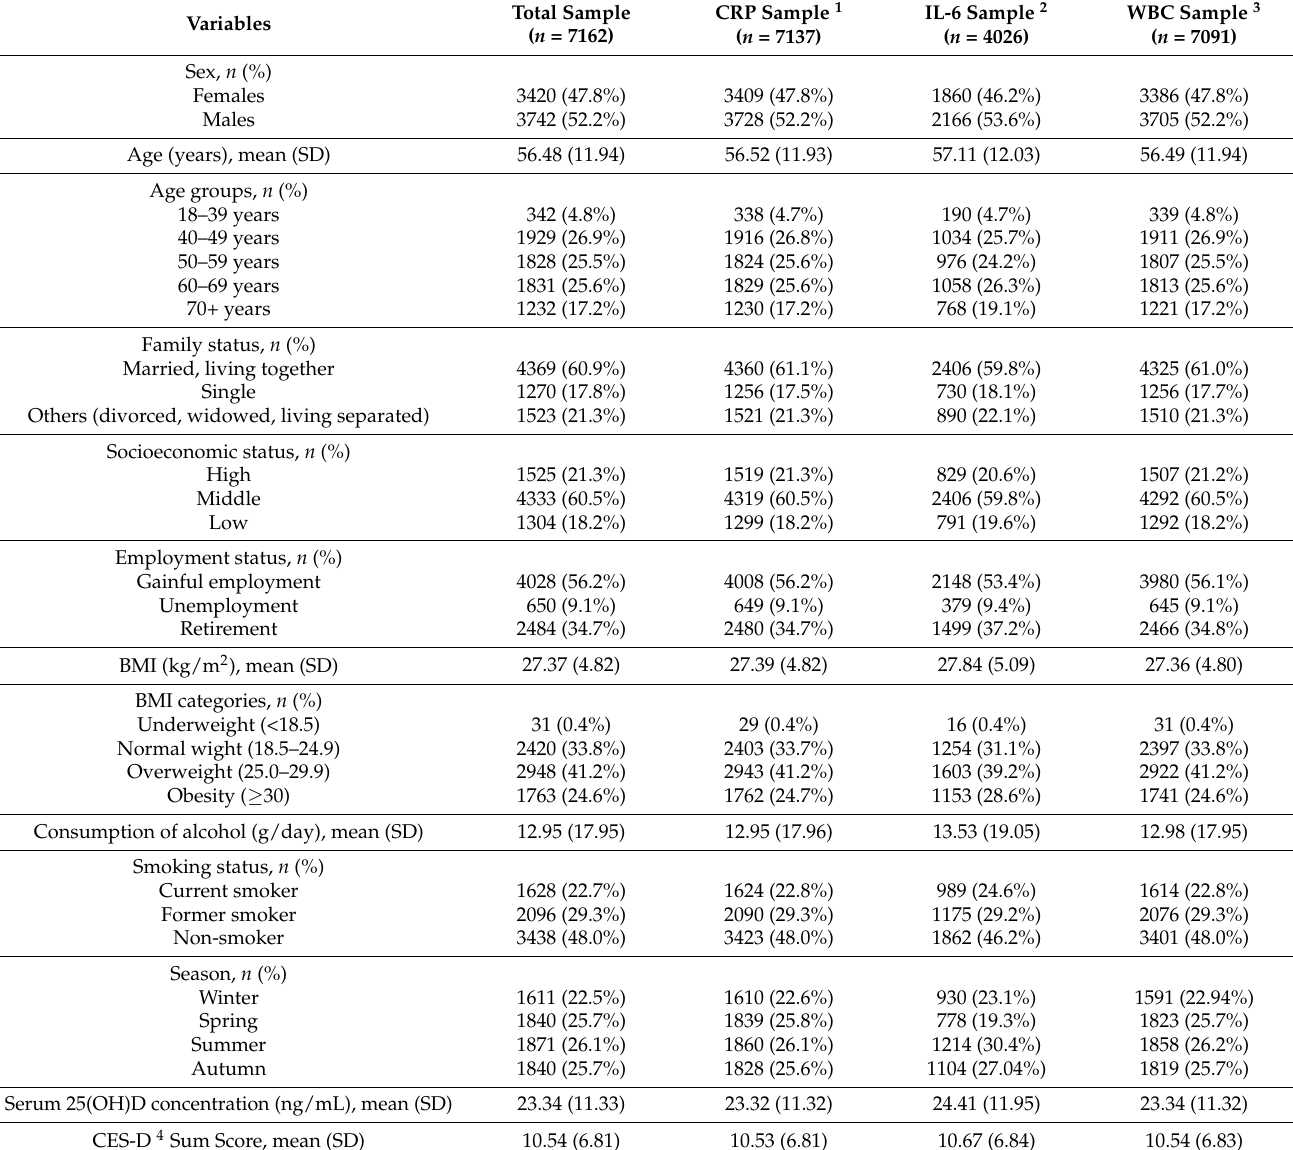
Table 1. Characteristics of the final sample as well as three analysis